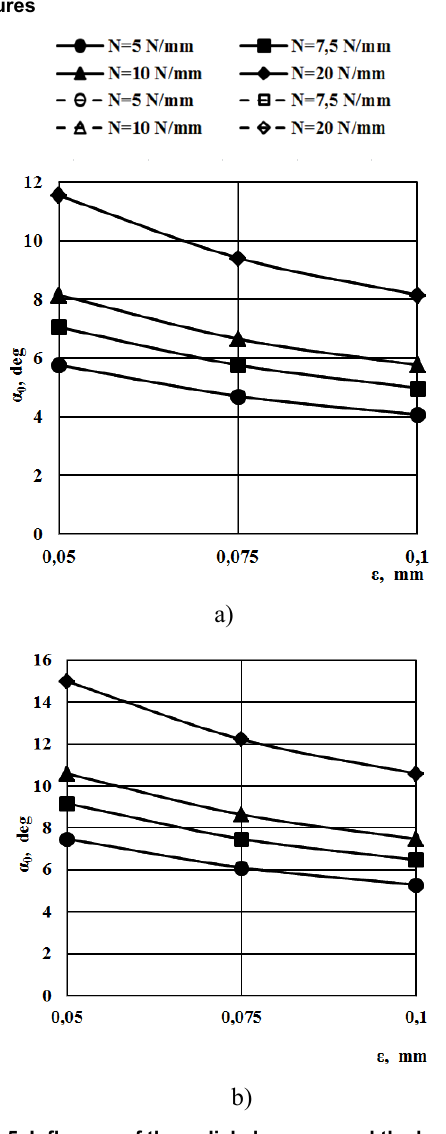
Figure 4. Influence of the wear on the maximum contact pressures